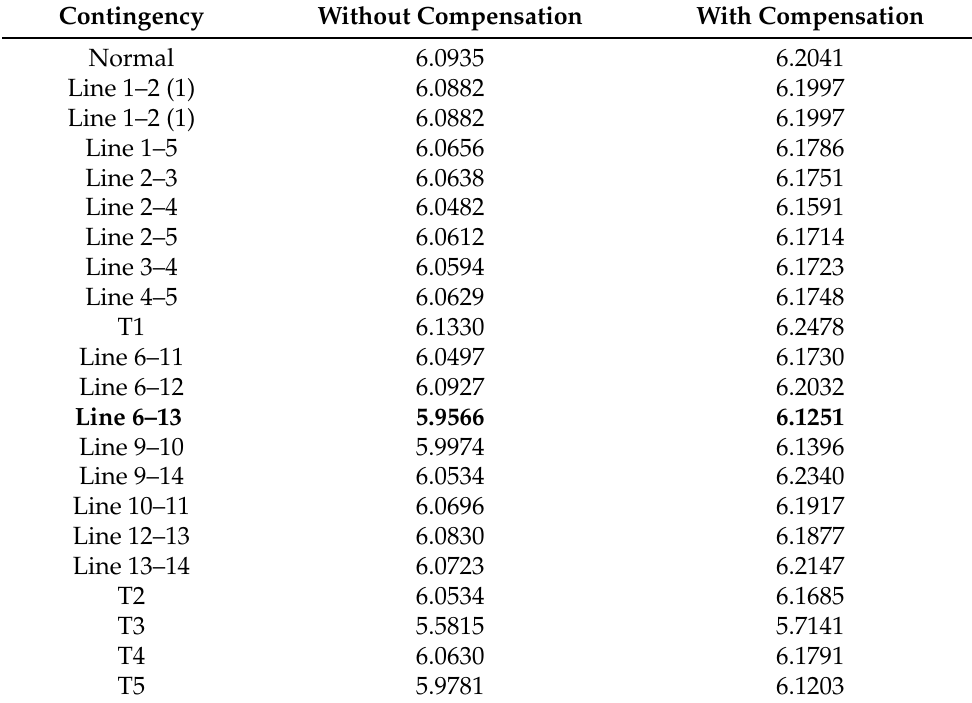
Table 2. Contingency index of the IEEE 14-bus bar